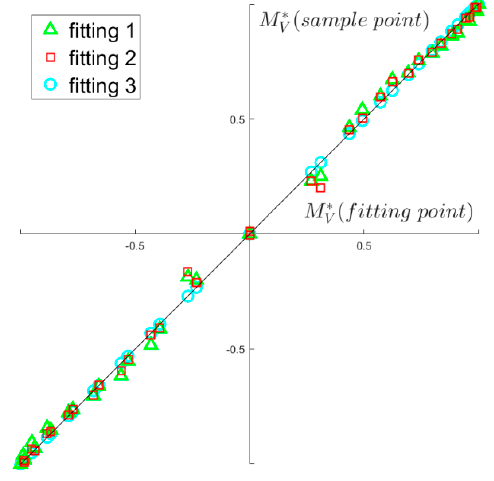
Figure 23. The case of a damaged hull due to stranding.